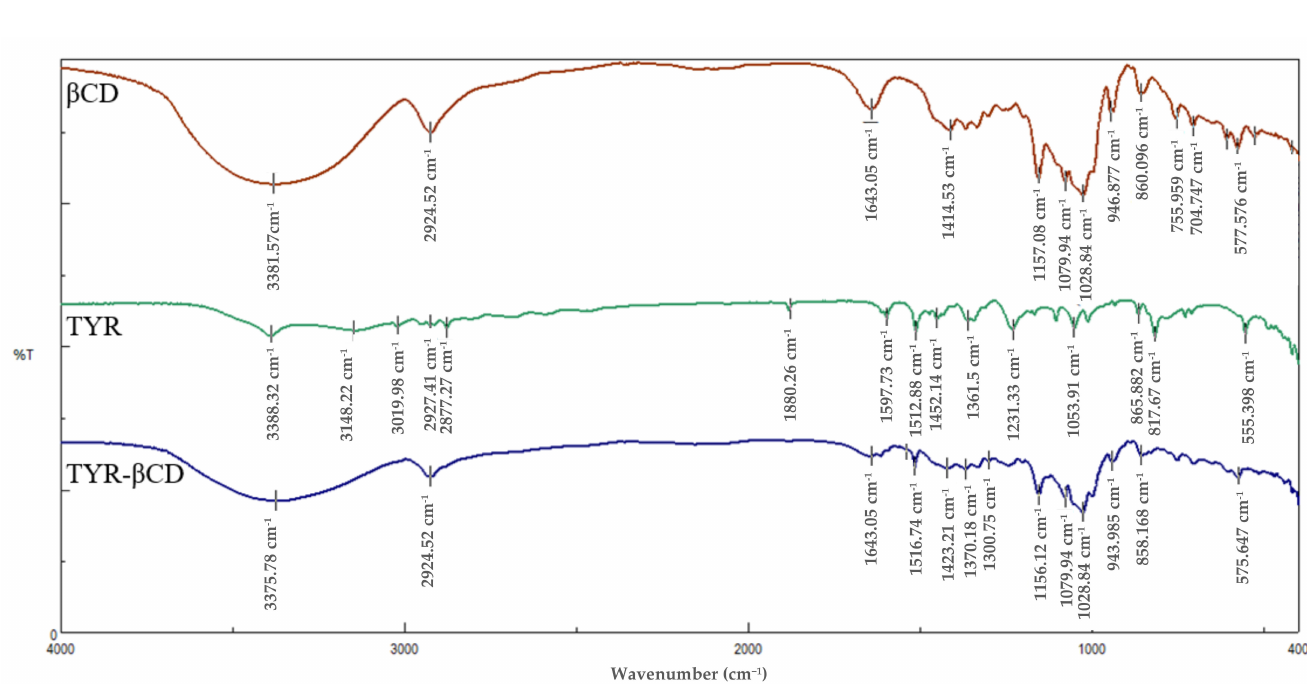
Figure 8. FT-IR spectra of β -CD (red), tyrosol (green) and tyrosol- β -CD inclusion complex (blue). The FT-IR spectrum of the inclusion complex of tyrosol with β CD (TYR- β CD) shows a broad absorption band at 3376 cm − 1 owed to the OH stretching vibration. This band is shifted compared to the corresponding band at the spectra of pure β CD (3382 cm − 1 ) and tyrosol (3389 cm − 1 ). This shift is indicative of strong interactive forces between the host and guest in the inclusion complex. The band at 1543 cm − 1 present in the FT-IR spectrum